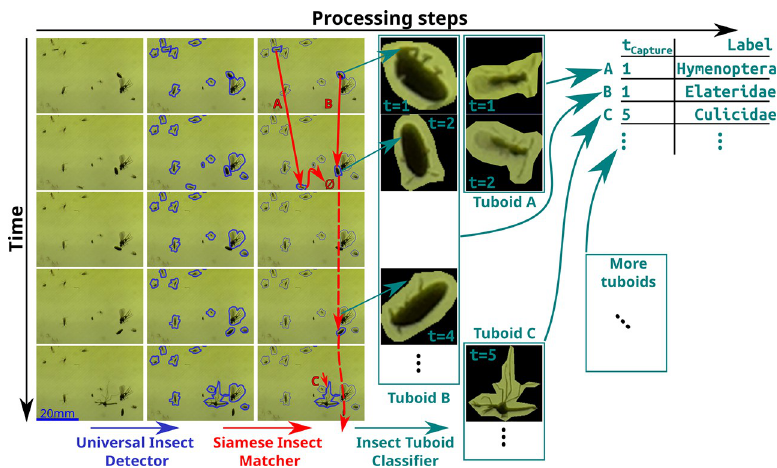
Fig 2. Overview of the image processing workflow. Devices acquire images approximately every 20 minutes, which results in a 500 image-long series per week per device. Rows in the figure represent consecutive images in a series. Series are analysed in 3 main algorithms (left to right). First, the Universal Insect Detector applies a 2-class Mask R-CNN to segment insect instances (versus background), blue. Second, the SIM applies a custom Siamese network– based algorithm to track instances throughout the series (red arrows), which results in multiple frames for the same insect instance, i.e., “insect tuboids. Last, the Insect Tuboid Classifier uses an enhanced ResNet50 architecture to predict insect taxonomy from multiple photographs. S AU : AbbreviationlistshavebeencompiledforthoseusedthroughoutFigs 2 and 4 (cid:0) 6 : IM, Siamese Insect Matcher.